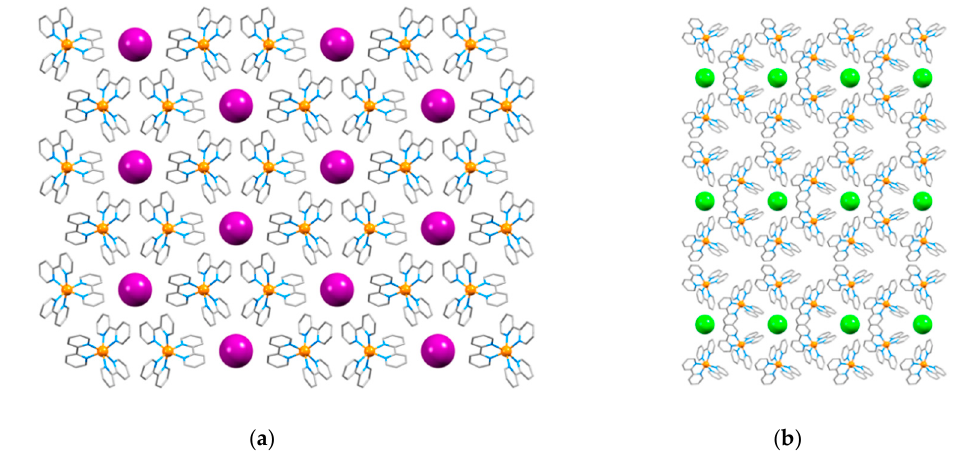
Figure 6. ( a ) The arrangement of adjacent anions in the typical Structure Type 1 sheet of ([Li(bpy) 3 ]I · bpy (RefcodeREXVOF)[92]. ( b )Inavariantfoundin[Ni(bpy) 3 ] 2 (C 4 H 4 O 6 )Cl 2 · 12H 2 O(RefcodeBPNTAR)[95], alternating rows of halides are missing from the sheets. Halide ions are shown in a space-filling representation, metal atoms (orange) in ball and stick representations and all other elements in CPK colours. Hydrogen atoms are omitted for